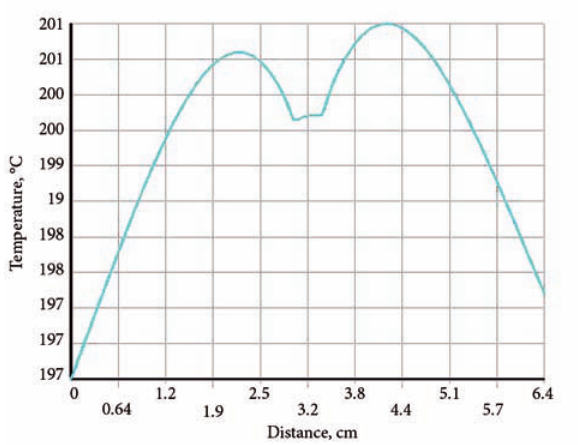
Fig. 16. Main residual stress s fields as joint is cooling down to 1 room temperature,